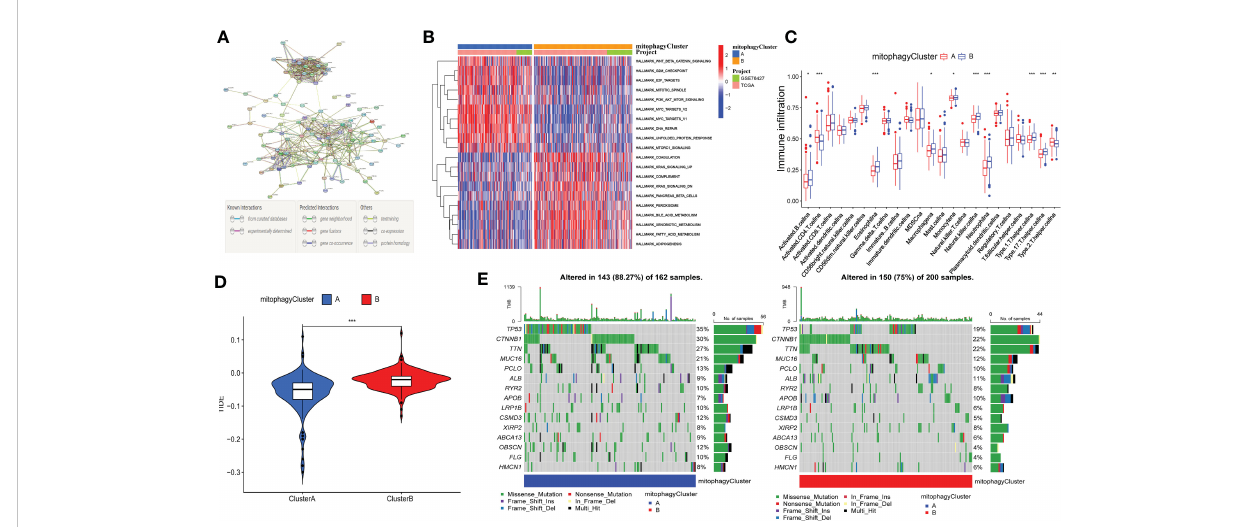
FIGURE 5 Correlation between mitophagy-related patterns and the TIME. (A) The protein-protein interaction network of DEGs. (B) Heatmap of GSVA analysis results. (C) The 23 immune cells shown in cluster A and cluster B with boxplots (*p < 0.05, **p < 0.01, ***p < 0.001). (D) The relative distribution of TIDE was compared between cluster A and cluster B. (E) The 30 genes with the highest mutation rate of cluster A and cluster B in Waterfall